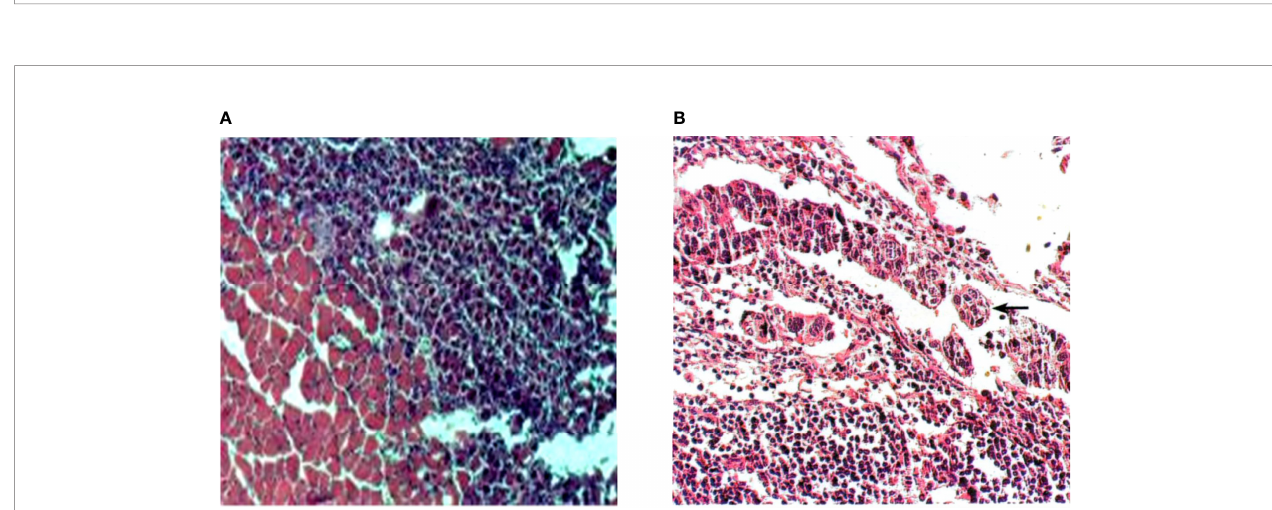
FIGURE 7 | The inhibitory effects of free drug and the nano-drug delivery systems on cell proliferation.